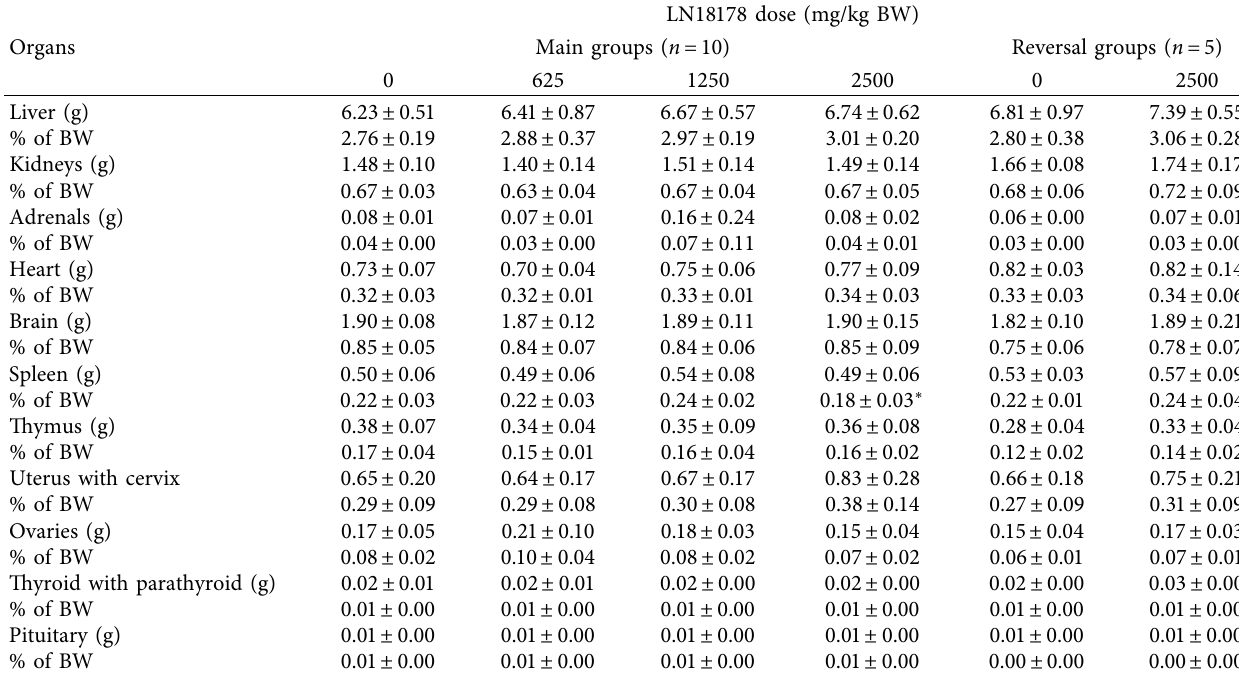
Table 6: Effect of 90-day oral administration of LN18178 on the absolute and relative organ weights of female Wistar rats.